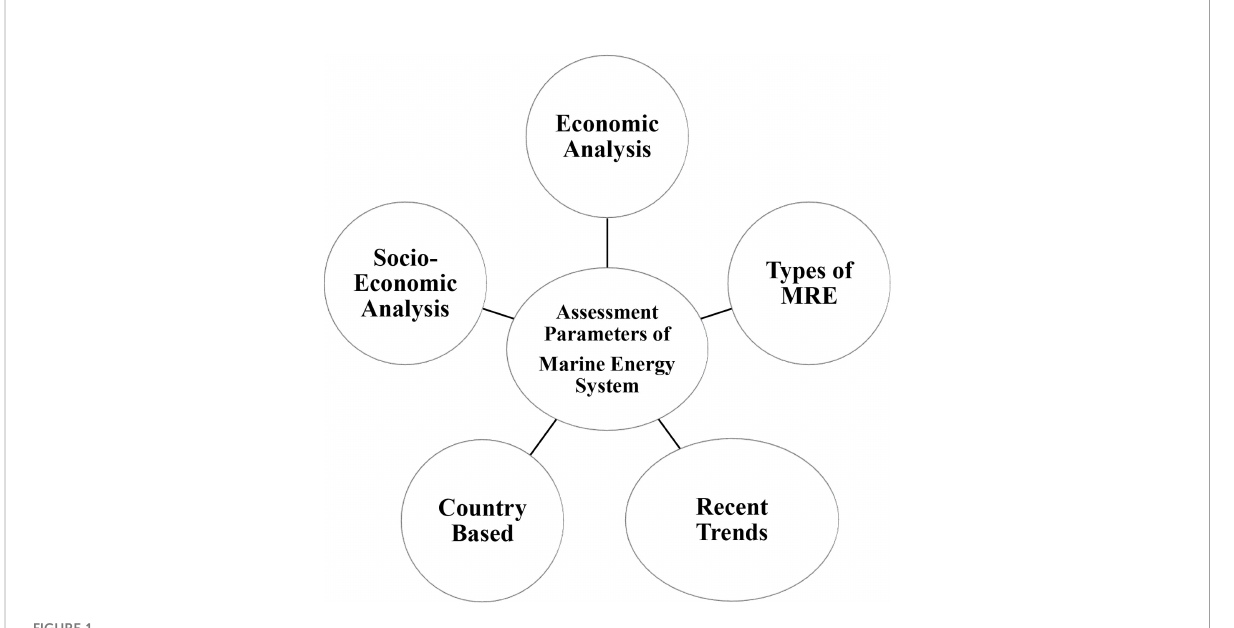
FIGURE 1 Assessment Parameters of Marine Energy